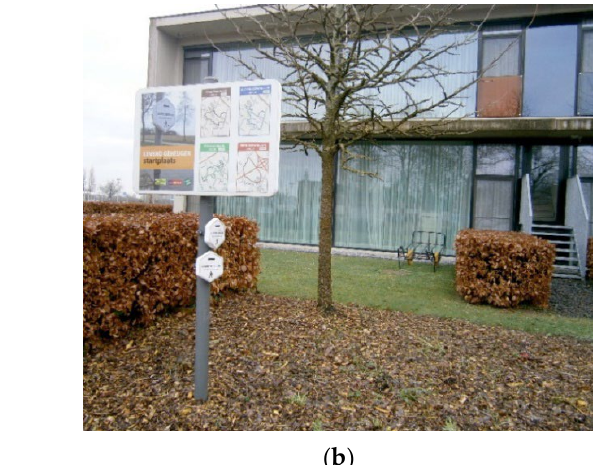
Figure 12. Selection of main pictures of the WZC De Weister project. Source: Own elaboration, 2020. ( a ) Near the WZC De Weister, there is an intergenerational park with musical instruments that stimulate social interaction. The park also includes gymnastic elements to train and keep fit with low impact exercises. ( b ) An innovative project that answers all the strategic lines that are defined in the dementia-friendly plan is the Reminiscence Walks, where four itineraries have been defined with the local community, connecting heritage elements across the village and promoting healthy habits and social interactions.